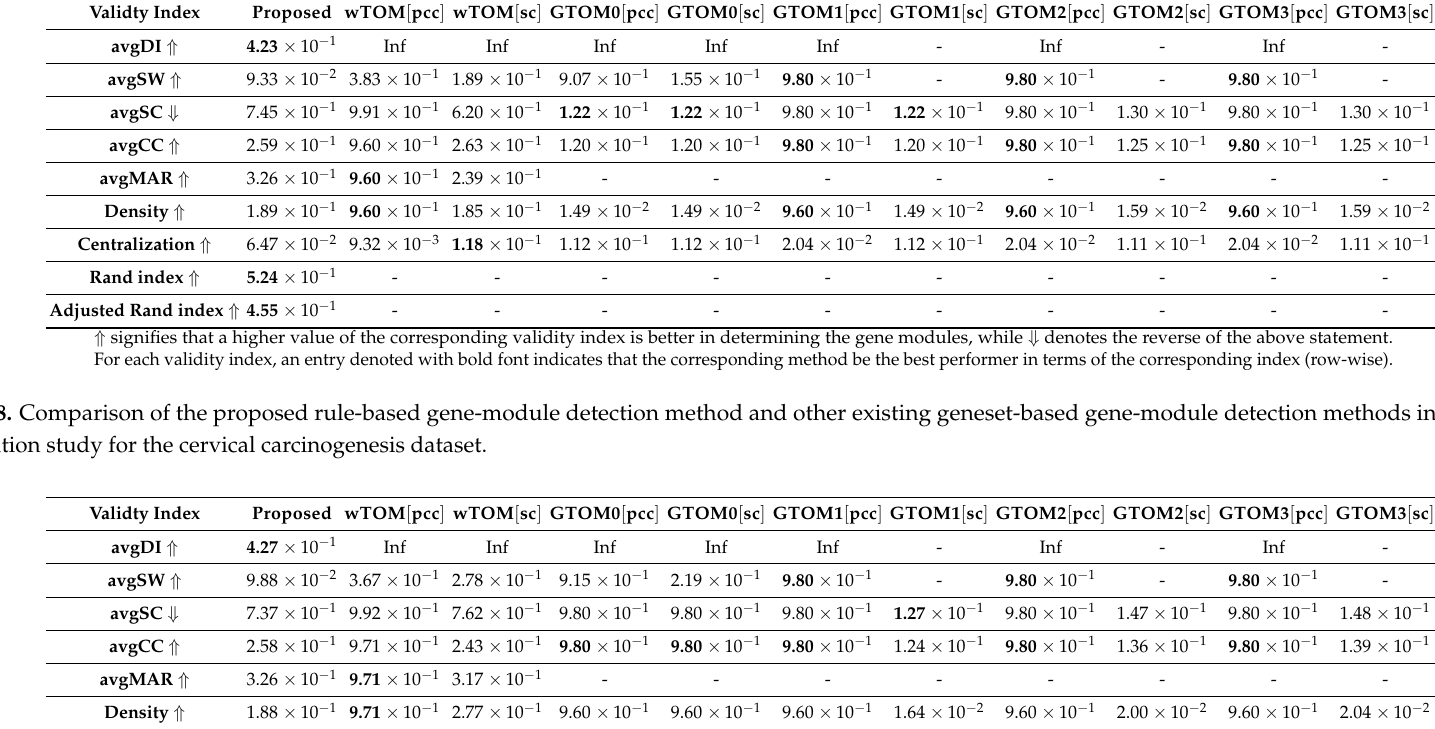
Table 7. Comparison of proposed rule-based gene-module detection method and other existing geneset-based gene-module detection methods in the first simulation study for the cervical carcinogenesis dataset.